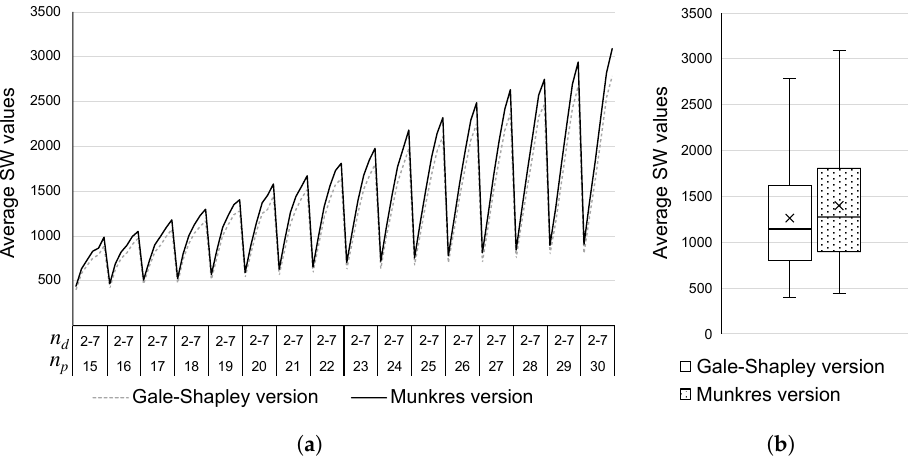
Figure 5. Average SW values of the proposed stable matching algorithm when using the Gale–Shapley version versus the Munkres version. ( a ) SW behavior in the increment of the number of passengers and drivers. ( b ) boxplot considering all the